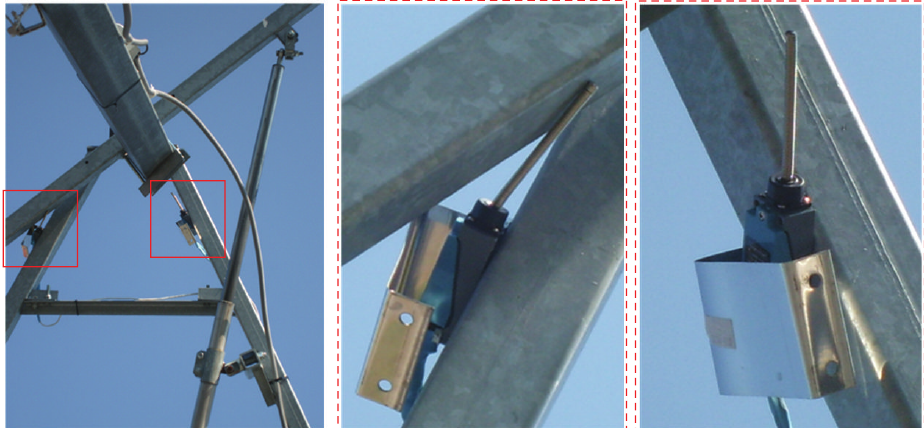
Figure 13: Location of the end sensors on the construction.